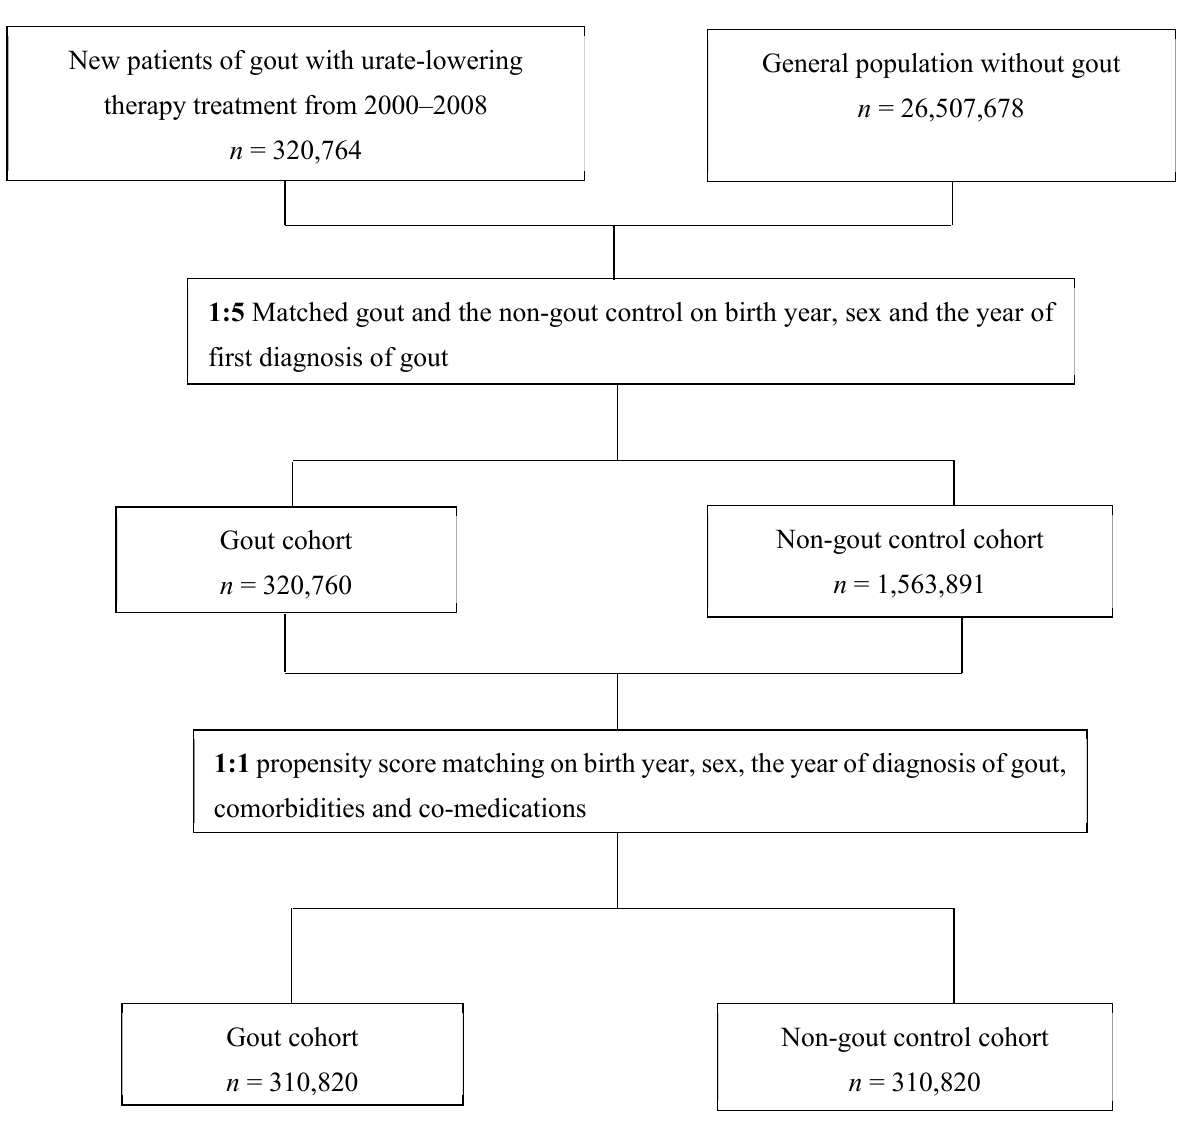
Figure 1. Patient selection flow.